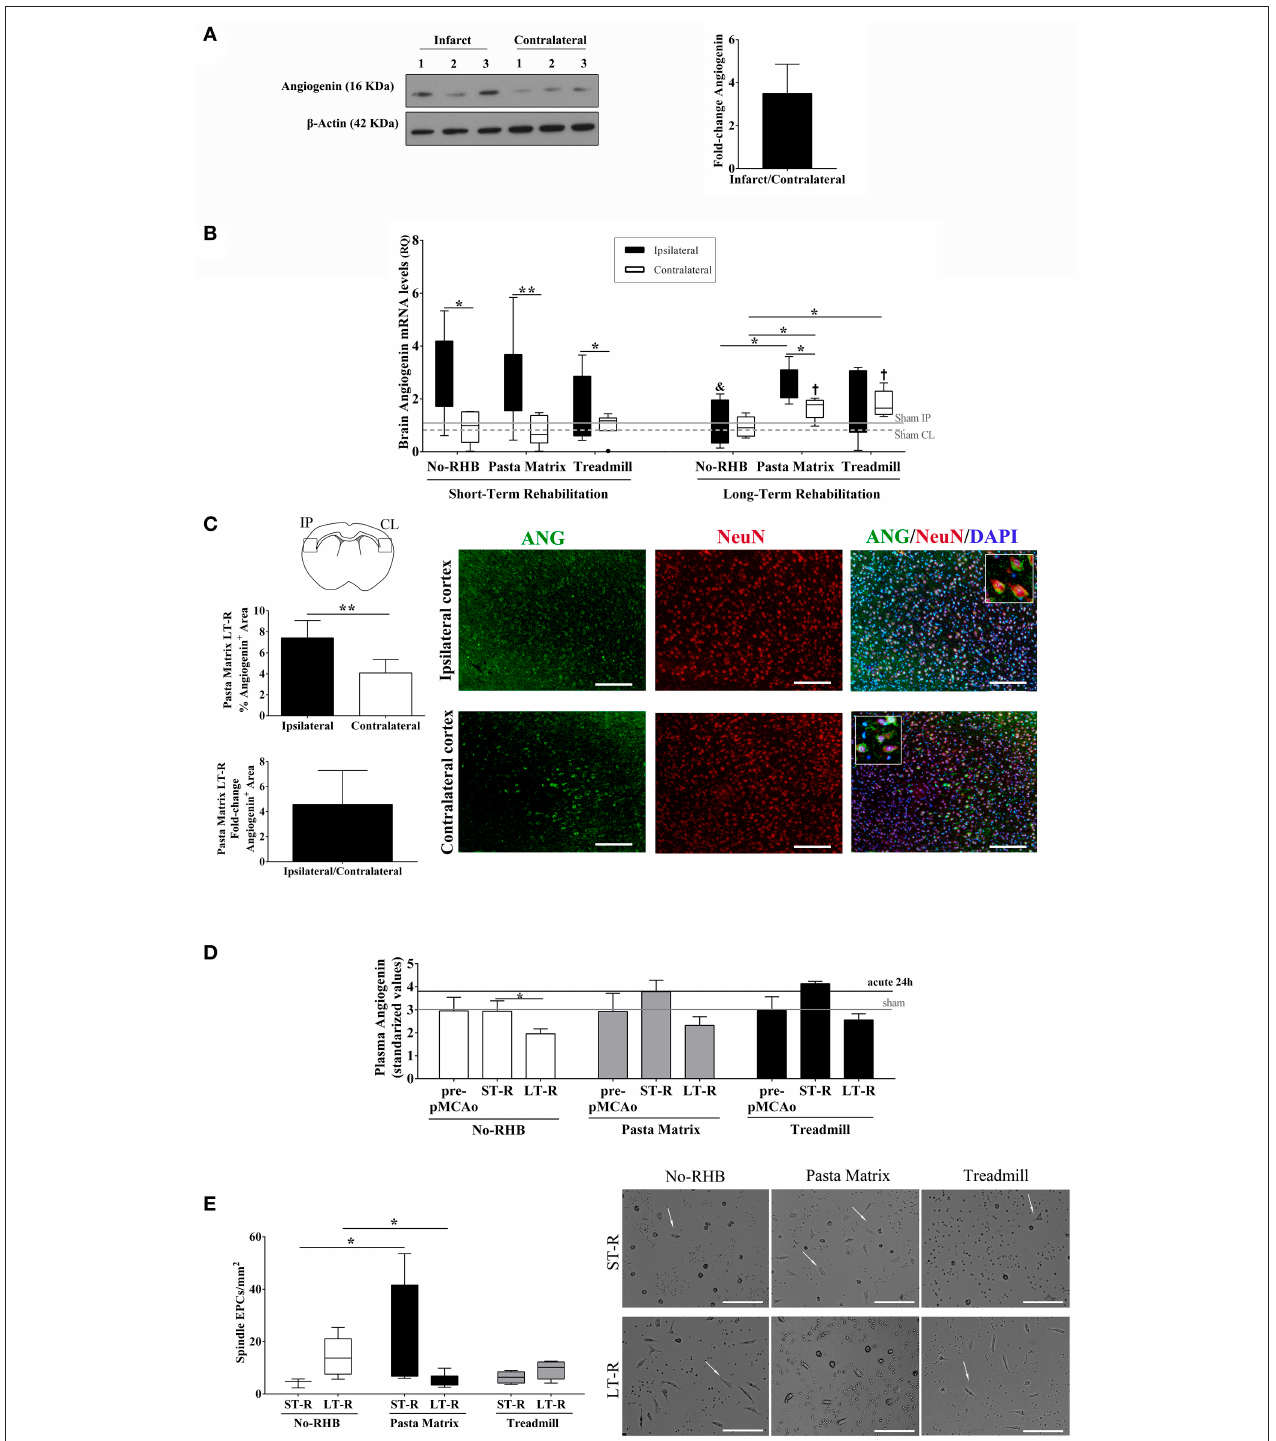
FIGURE 6 | Angiogenin and EPCs modulation after mouse cerebral ischemia and rehabilitation. (A) Infarct and contralateral mouse brain cortical homogenates were analyzed by western blot to quantify angiogenin protein ( n = 3). The densitometry results (arbitrary units) were corrected by the actin load and are represented as fold-change of the ipsilateral vs. contralateral signal. (B) Bar graphs representing the angiogenin RNA expression in the ischemic and contralateral cortex in the short-term ( n = 6–9) and long-term rehabilitation groups ( n = 5), ** p < 0.01, * p < 0.05 as indicated by horizontal lines. Non-RHB ipsilateral short-term vs. long-term; & p < 0.05. Pasta Matrix and Treadmill contralateral short-term vs. long-term; † p < 0.05. (C) Bar graphs showing the percentage of the Angiogenin + area in the